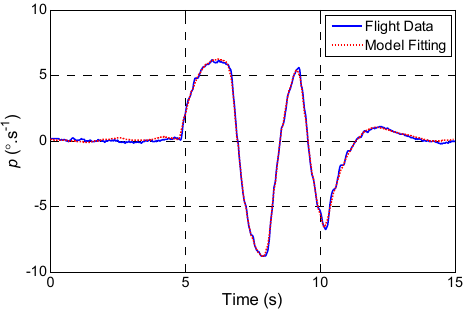
Figure 6. Fitting of roll velocity equivalent model after time delay calibration of control surface deflection data.